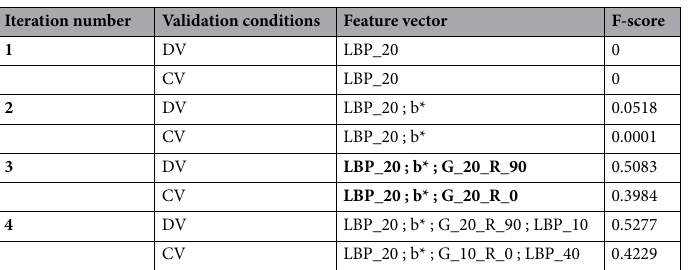
Table 6. Feature selection results for anti-Phox2B. Bold vector corresponds to the selected vector. The nomenclature is presented in Material and Methods.